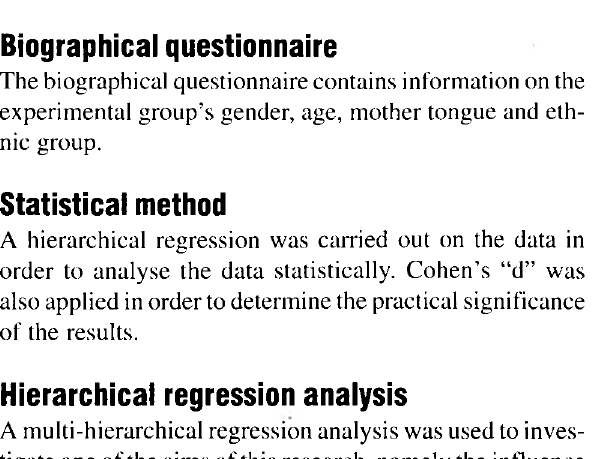
Table 2: The reliability coefficient of the measuring